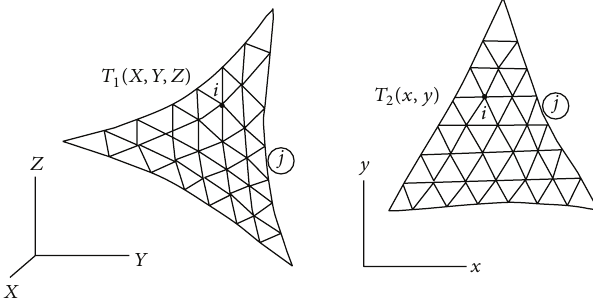
Figure 3: Shrinkage compensation from the initial state to the zero stress state.